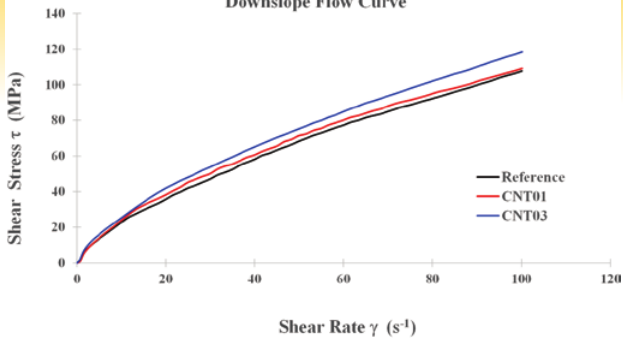
Figure 5 Shear stress versus shear rate relationships for the investigated cement